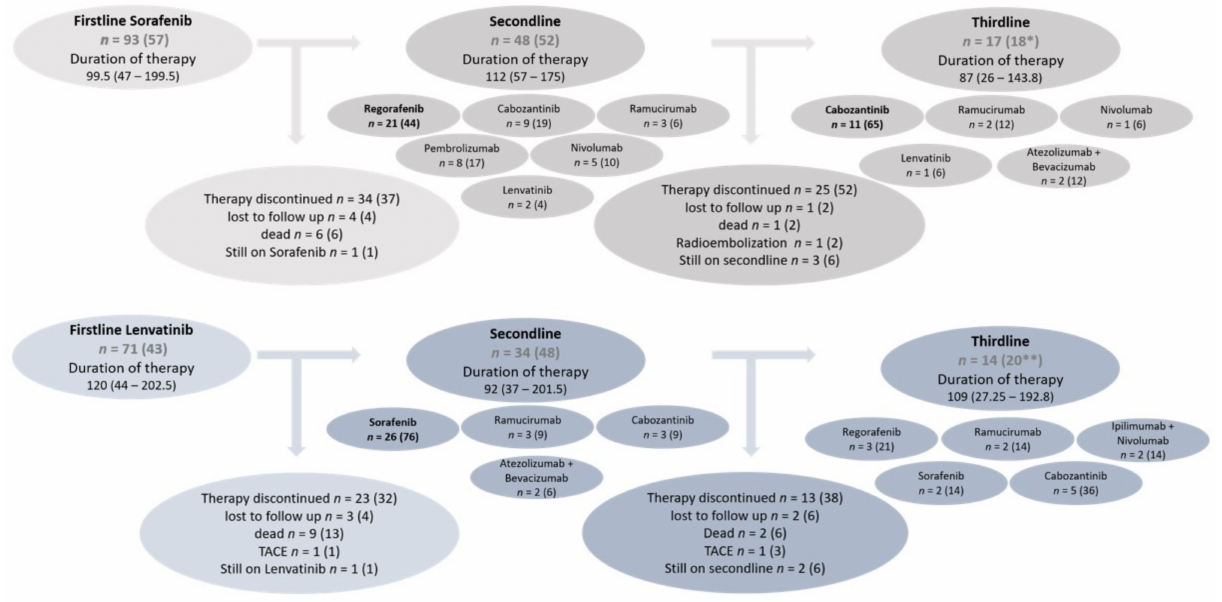
Figure 1. Flowchart of sequential systemic therapies starting either with sorafenib or lenvatinib